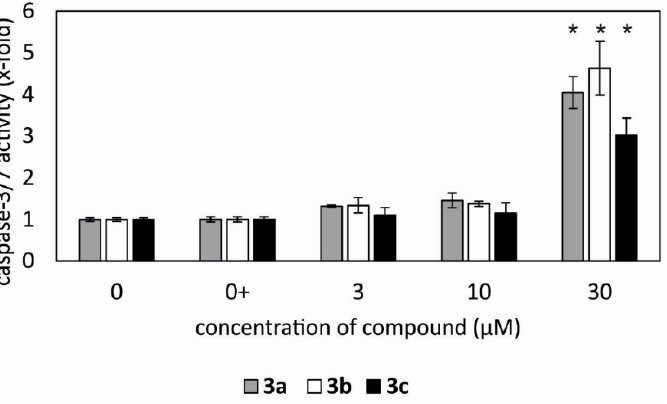
Figure 3. Activity of caspase-3/7. Activity of caspase-3/7 after 24 h treatment with 3a–3c (3, 10 and 30 µM) in HeLa cells. The bars 0 are control untreated cells, the bars 0+ are control cells with DMSO. The experiment was repeated at least twice in duplicates. All data were analyzed by statistical software. Significance is indicated with an asterisk (*) ( p <